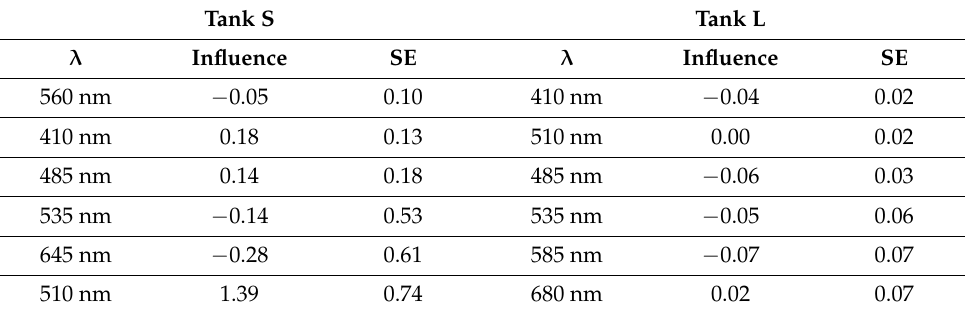
Table 9. Comparison of the most accurate wavelengths for Tank S and Tank L. Tank S Tank L λ